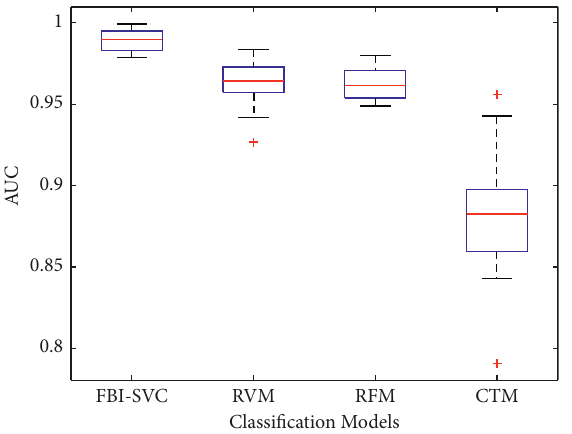
Figure 15: Box plot of AUC values obtained from the employed machine learning models. Table 2: p values obtained from the Wilcoxon signed-rank test results with CAR index.